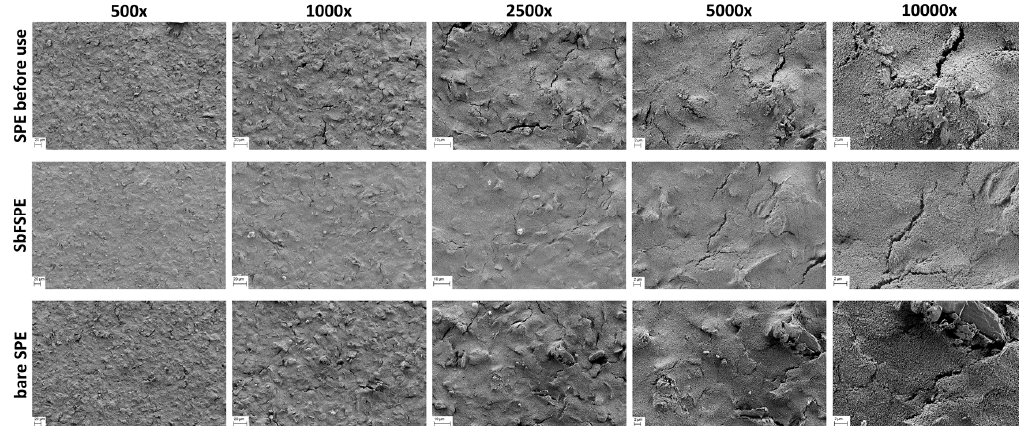
Figure 7. SEM images measured on the surface of three different sensors: top row: SPE sensors before use, middle row: SbFSPE sensors after being used five times, and bottom row: bare SPE after being used five times by employing the multiple standard addition method. In the case of used samples, the same experimental conditions were employed as in Figure